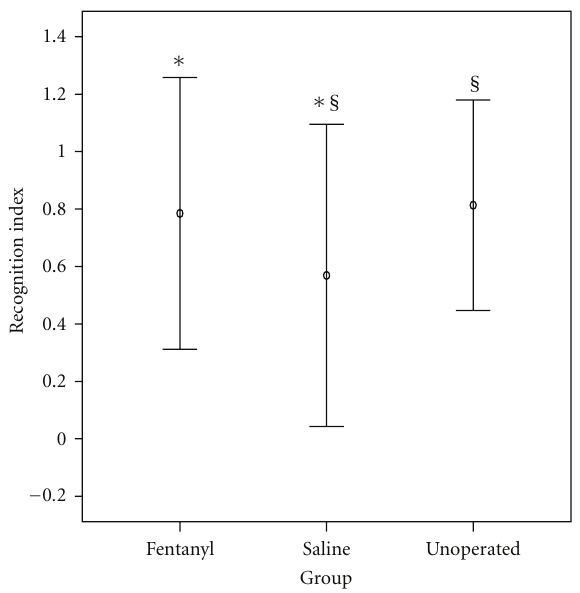
Figure 5: Object recognition test of short-term memory. Recogni- tion index of novel object exploration is exploration time on new object/total exploration time (RI = t n / ( t n + t f )). The recognition index (RI) of a novel object in fentanyl group was not significantly di ff erent from that for the unoperated sham controls. However, a significant di ff erence ( ∗ P = 0 . 045) was evidenced between the fentanyl group compared to the saline group, showing better cognitive function for the first group. A di ff erence was also seen between the controls: unoperated sham rats displayed significantly ( § P = 0 . 025) better short-term memory compared to saline-treated rats. Values are mean ±